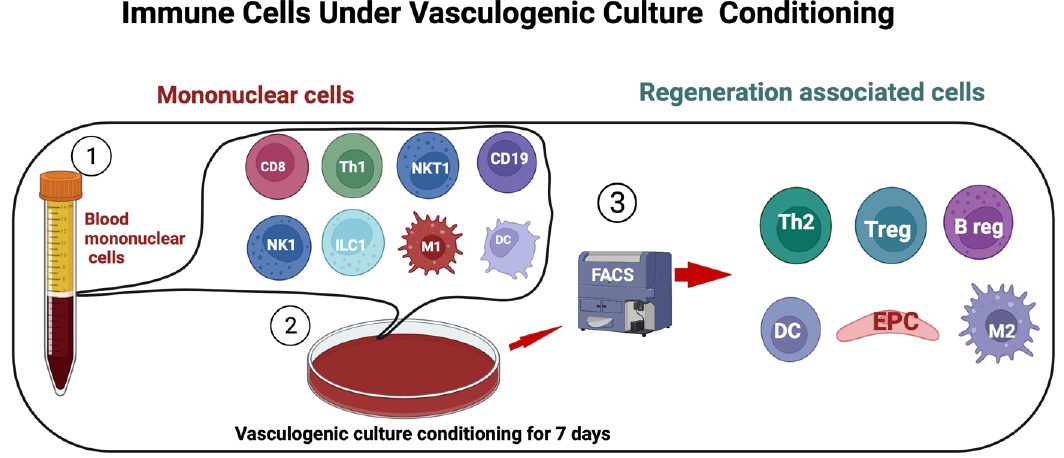
Figure 2. Regeneration-associated cells. PBMCs isolated and cultured in serum-free media with de- fined growth factor for 7 days and analyzed by flow cytometry. The proinflammatory cell phenotypes shift to anti-inflammatory phenotype cells such as EPC, alternatively activated macrophages M2 φ , Th2, and regulatory T cells.